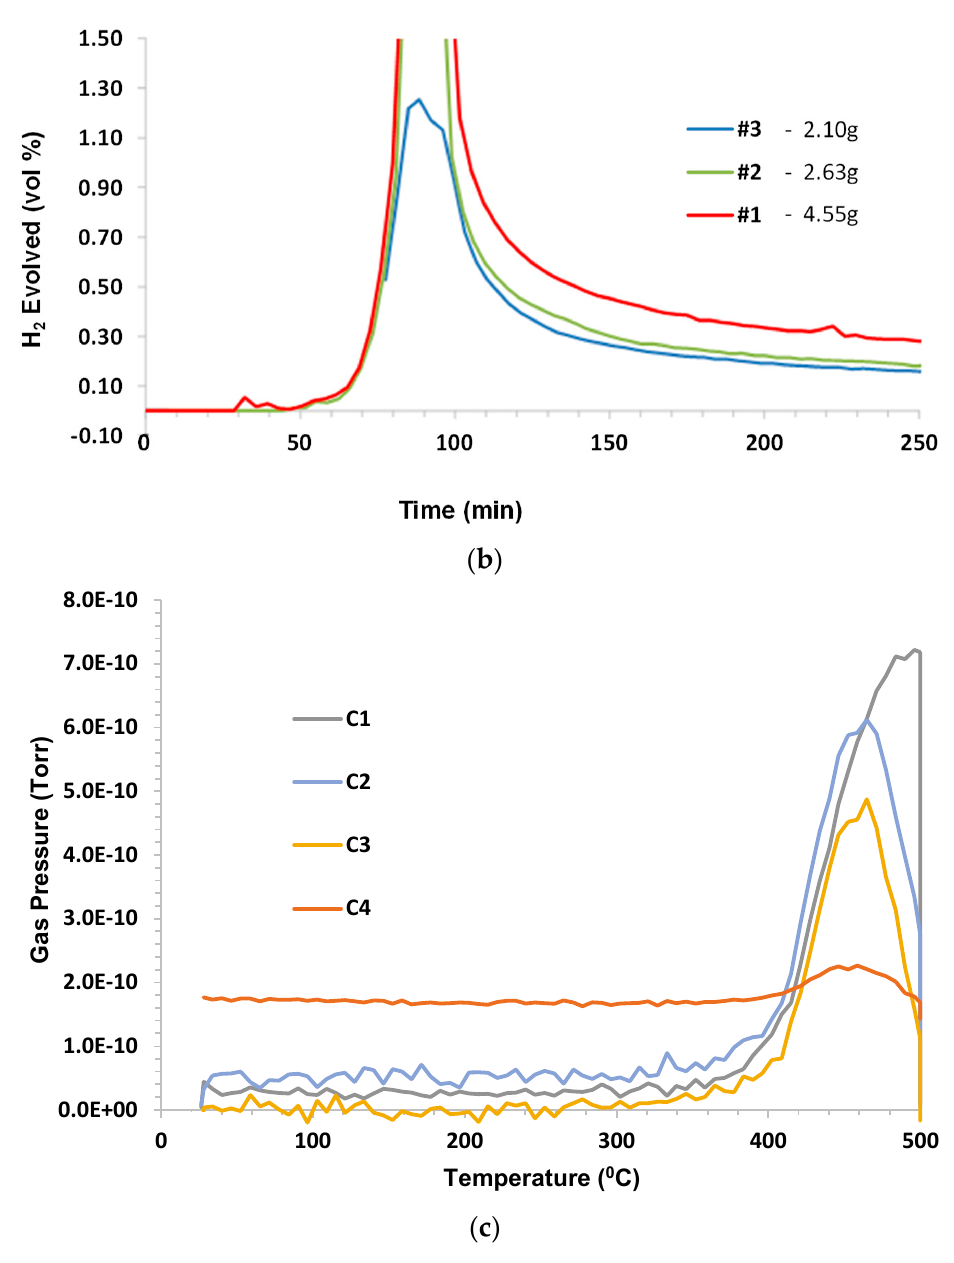
Figure 8. Pennsylvanian Shale in humid CO 2 . ( a ) Gas pressure and temperature as a function of time. ( b ) H 2 evolved (vol%) as a function of time. ( c ) Gas pressure as a function of temperature. These results indicate an even lower temperature for pyrolysis onset, i.e., 360 ◦ C.